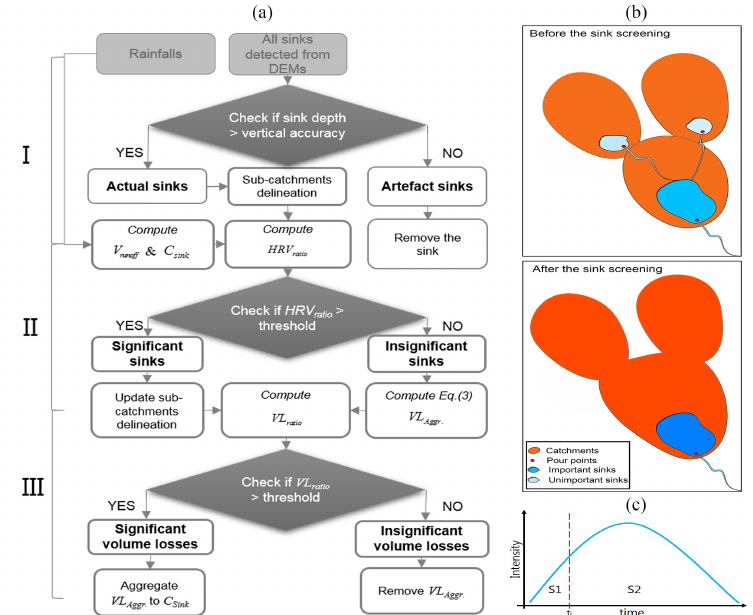
Figure 1. ( a ) The workflow behind the VRSS method, where light grey boxes represent input data; Step I represents the removal of artefact sinks; Step II represents a computationally significant sink selection; Step III represents the control of volume losses. ( b ) The sink screening process: before and after, where pour points denote a transition point indicating runoff converted from sheet flow (orange) to channel flow (blue lines). ( c ) Rainfall hyetograph, where the poor runoff retention sinks tend to be filled up rapidly before the time of t i , and a smaller HRV ratio indicates a smaller proportion of S 1 with earlier t i in relation to the temporal variation of a rainfall event. Notes: increasing blue colouring for sinks symbolizes larger